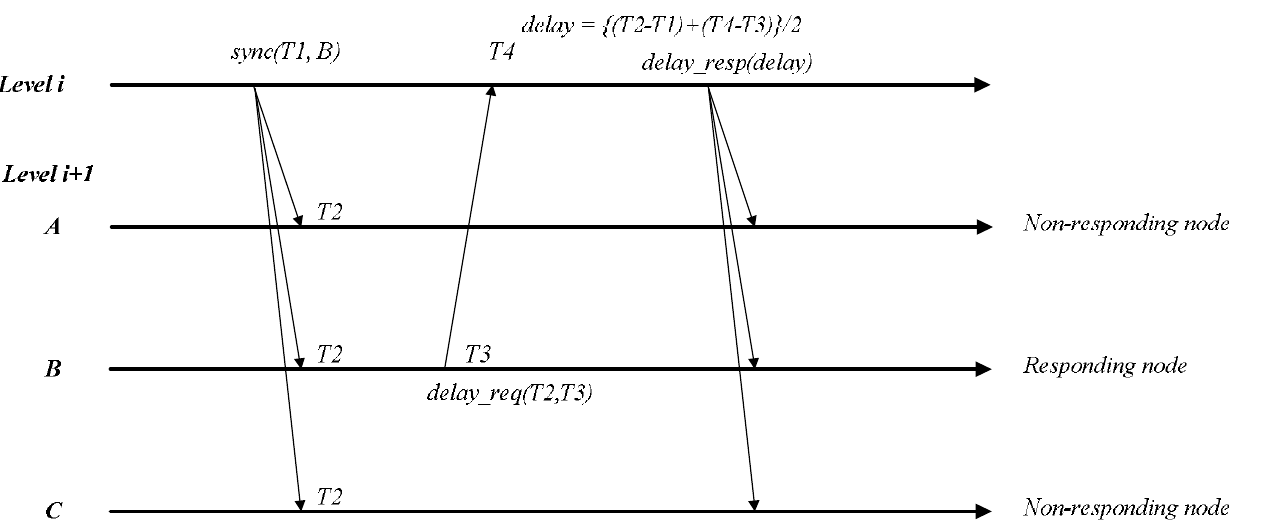
Figure 2. Lightweight time